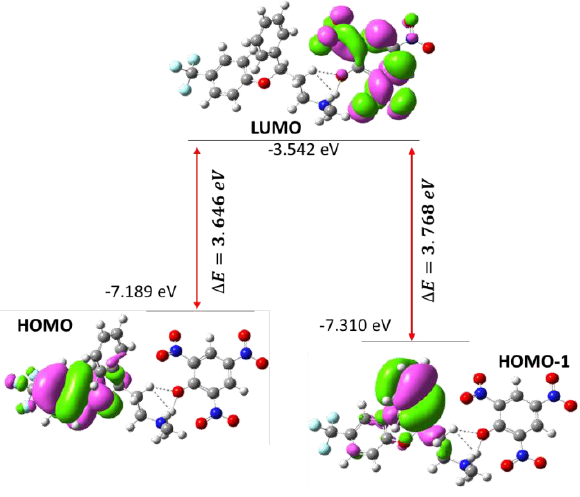
Figure 17. The energy gaps and spatial plot of HOMO and LUMO. The molecular orbital energy level diagram of the CT complex [(FXN)(PA)] is presented in Figure 18.